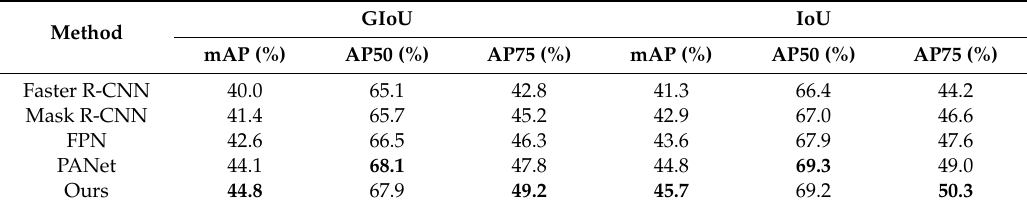
Table 4. Comparison with four state-of-the-art methods on DIOR dataset in terms of six evaluation metrics. Bold fonts denote the best results.